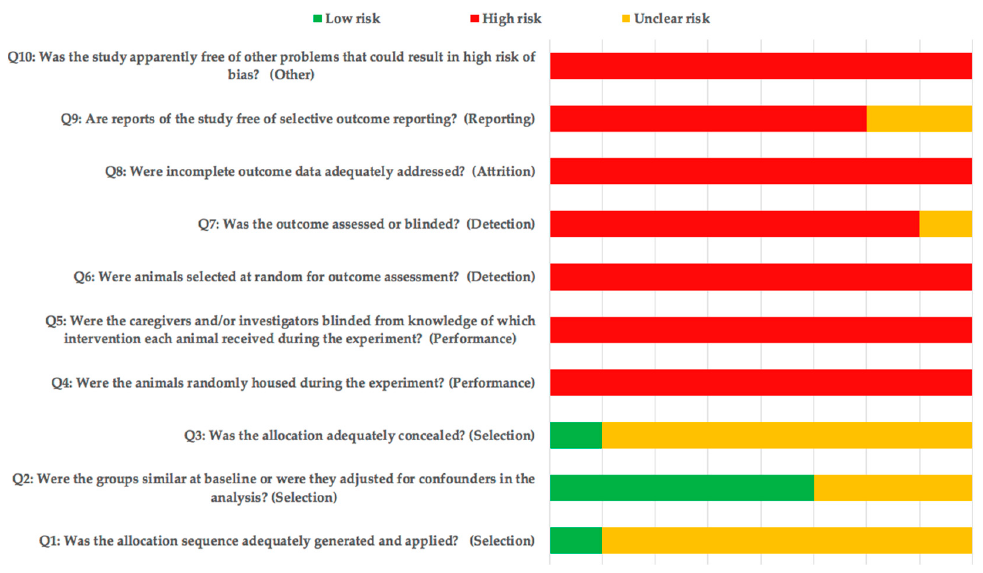
Figure 2. SYRCLE ’ s risk of bias tool. Figure 2. SYRCLE’s risk of bias tool.